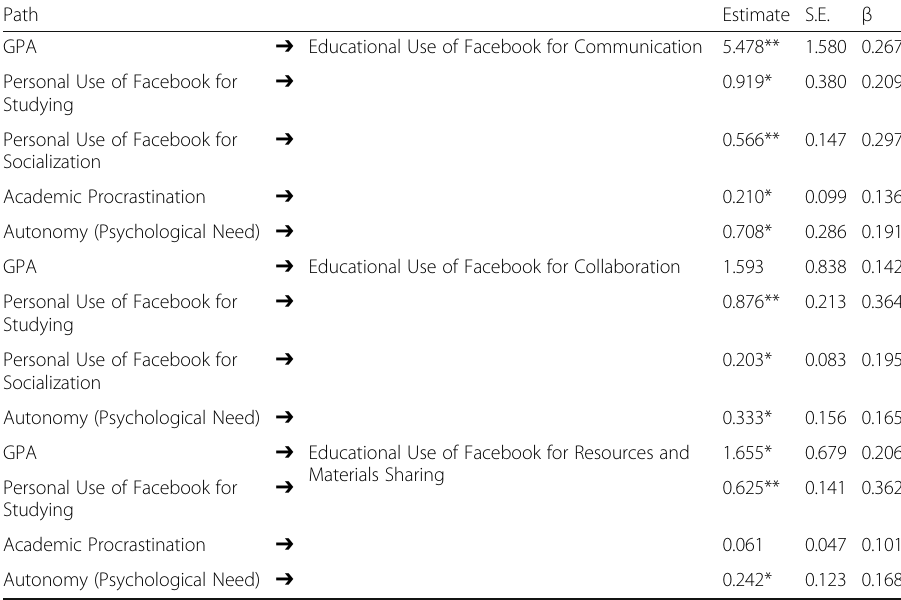
Table 6 Estimates of the paths in the model Path Estimate